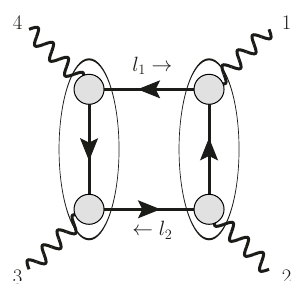
Figure 2 . A one-loop quadruple cut with circulating hypermultiplets | all four exposed lines are taken on shell. To compute it, we (cid:12)rst write it as a two-particle cut involving a pair of four-point tree amplitudes | as indicated by the transparent blobs | and then we multiply by the inverse poles exposed inside these blobs. The quadruple cut limit is then (cid:12)nite. the one-chiral-vector case (and its CPT conjugate), but we will not consider it here. All sectors are consistent with N = 2 supersymmetry, but the all-chiral integrand will only give rise to O ( (cid:15) ) contributions in D = 4 (cid:0) 2 (cid:15) dimensions. Nevertheless, the integrand